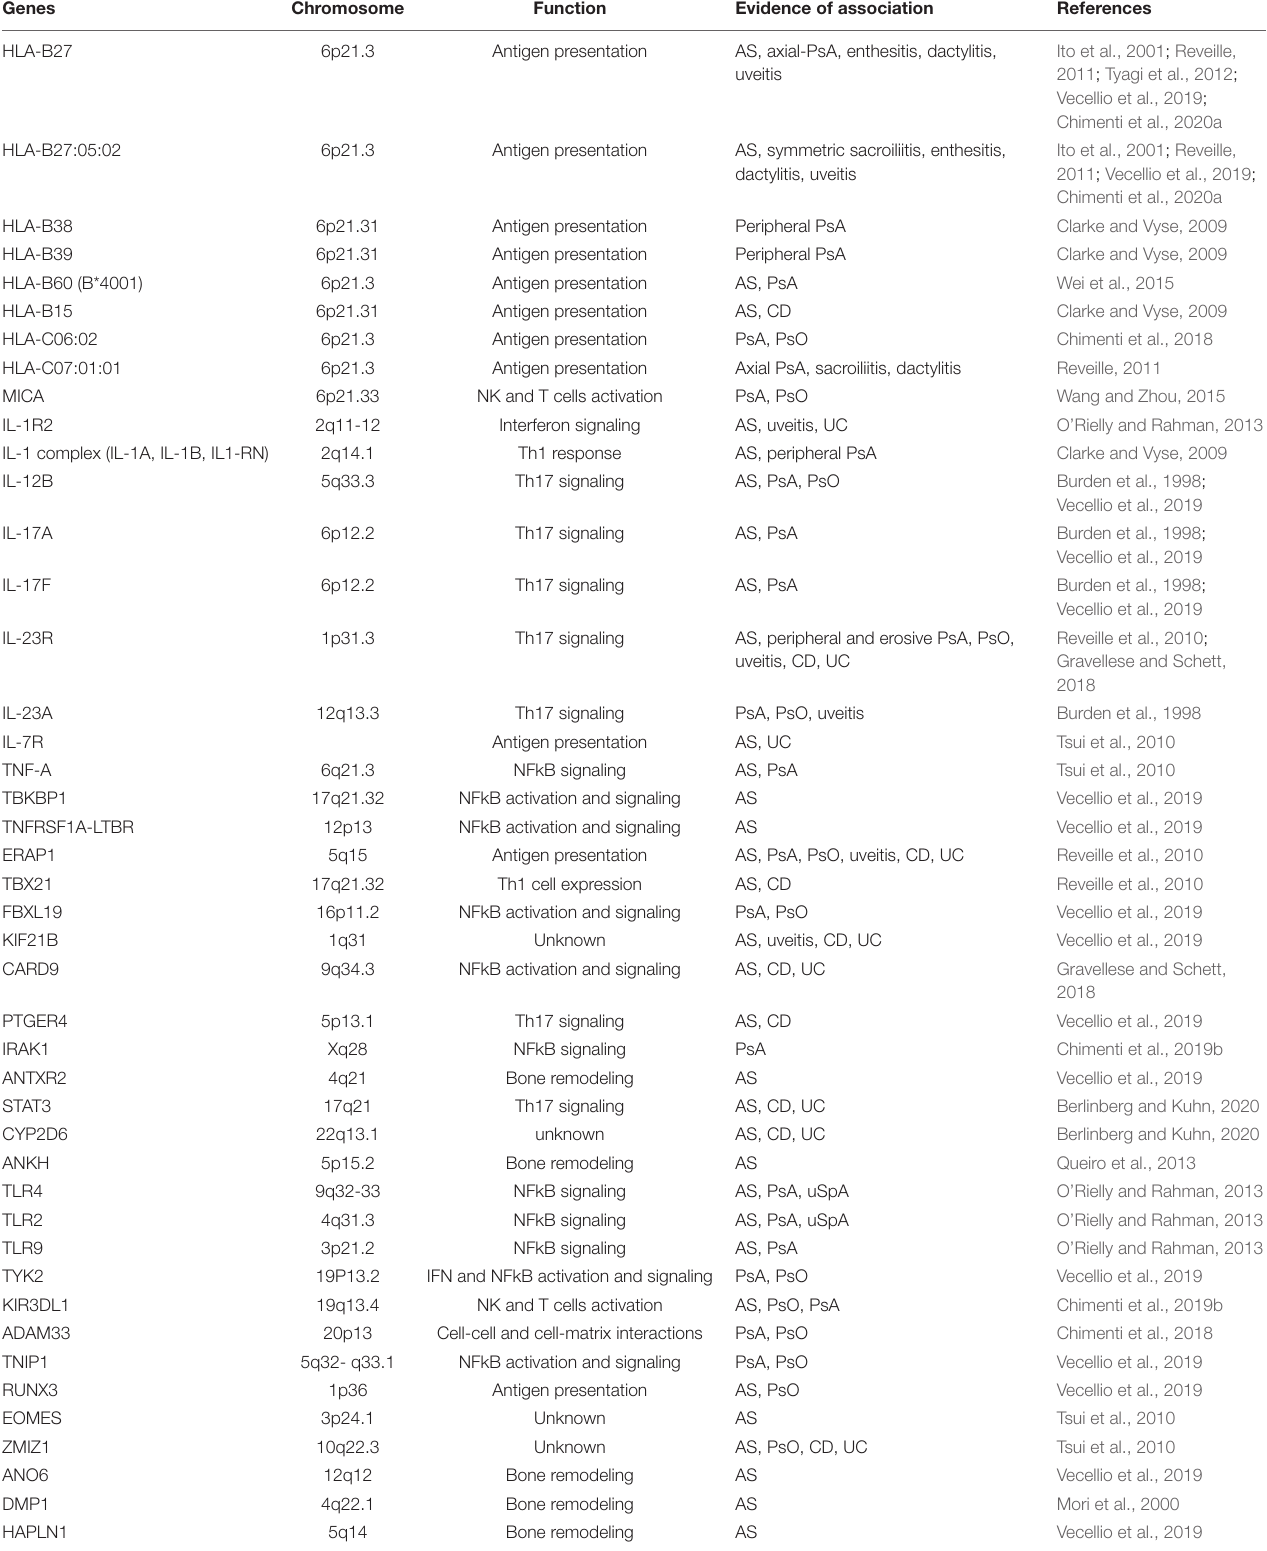
TABLE 1 | Genes whose variability is involved in